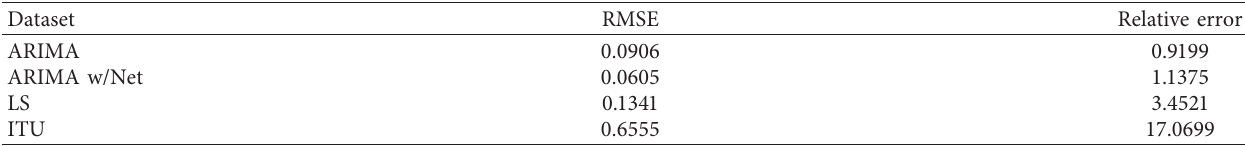
Figure 16: Comparison between measured data, ITU estimation, LS estimation and proposed modelling curves for (a) “data3” subscenario, (b) “data2” subscenario, and (c) “data1” subscenario. Table 15: ARIMA, ARIMA with neural network, LS, and ITU errors for “data3.”